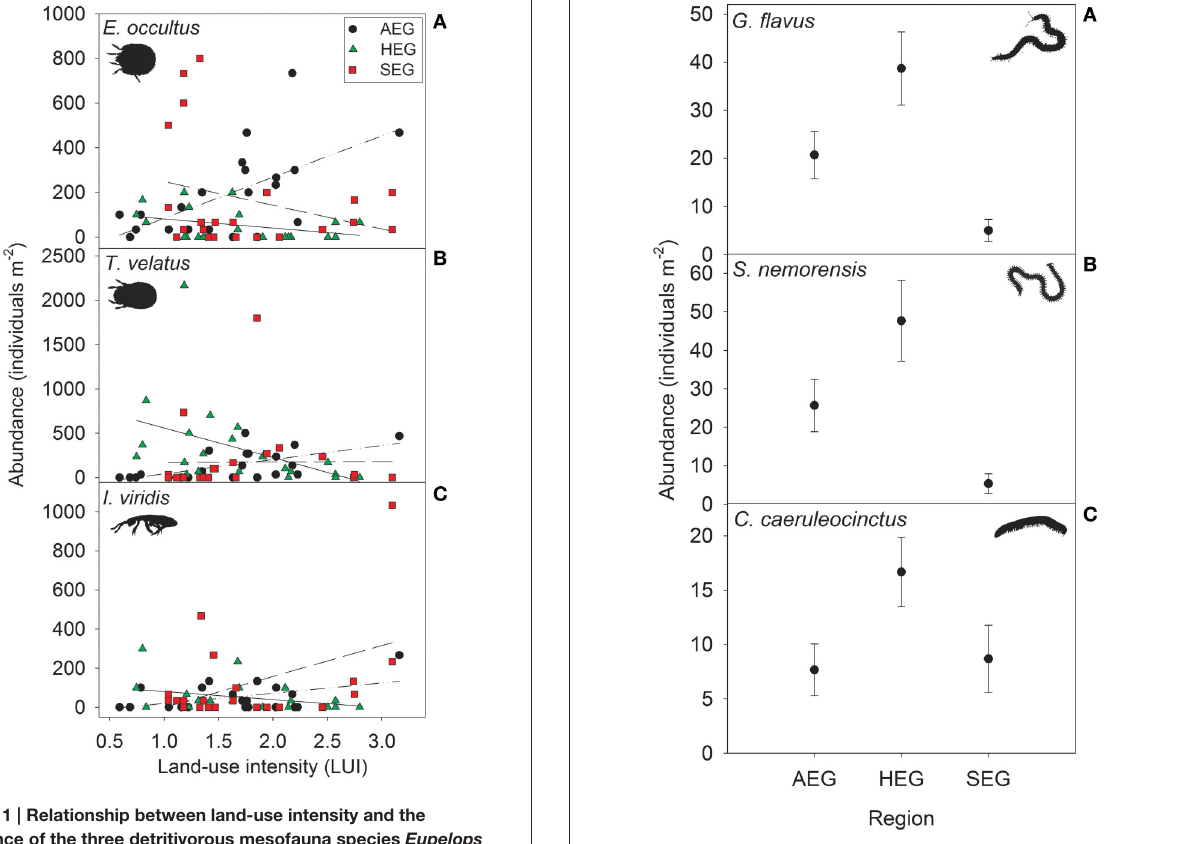
FIGURE 2 | Abundance (means ± SE) of the centipede species (A) Geophilus flavus and (B) Schendyla nemorensis and the millipede species (C) Cylindroiulus caeruleocinctus in grassland plots in the three study regions (see Table 1 for location and abbreviation of